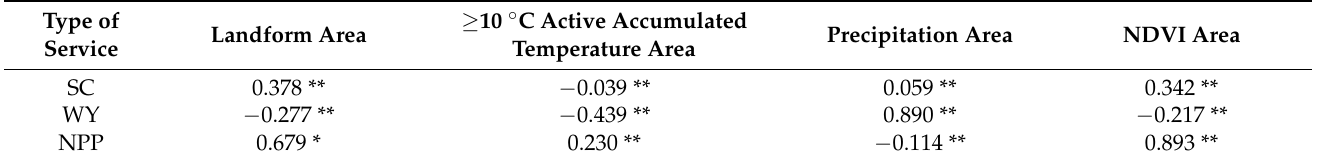
Table 6. Q statistics of spatially divergent impact factors of Ecosystem Services. Table 5. Correlation between Ecosystem Services and Influencing Factors.